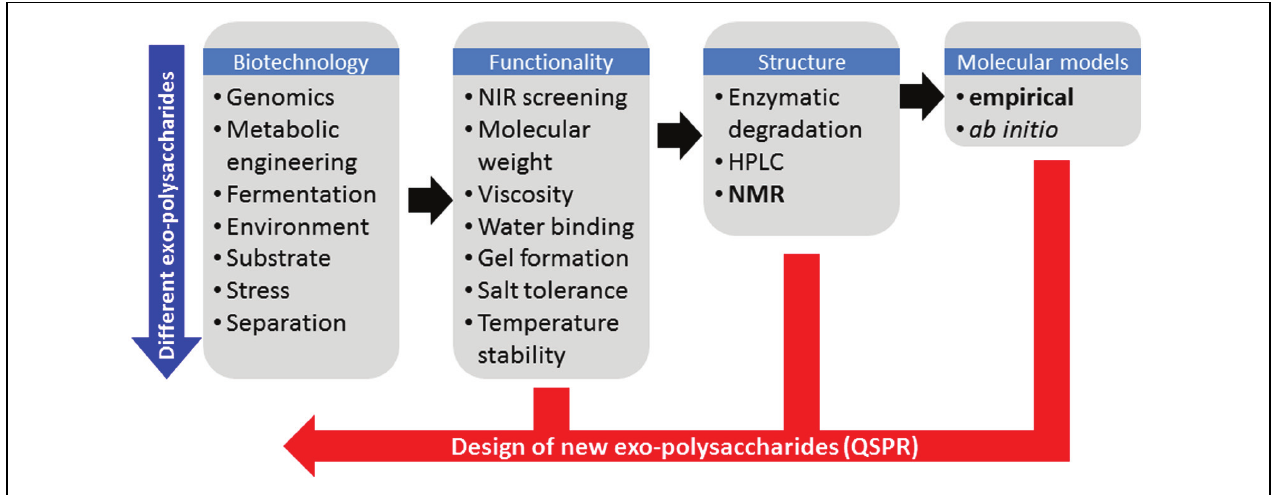
FIGURE 1 | Schematic overview of the work flow in tailoring exopolysaccharide functionality by first principles and by Quantitative Structure –Property Relationships (QSPRs).